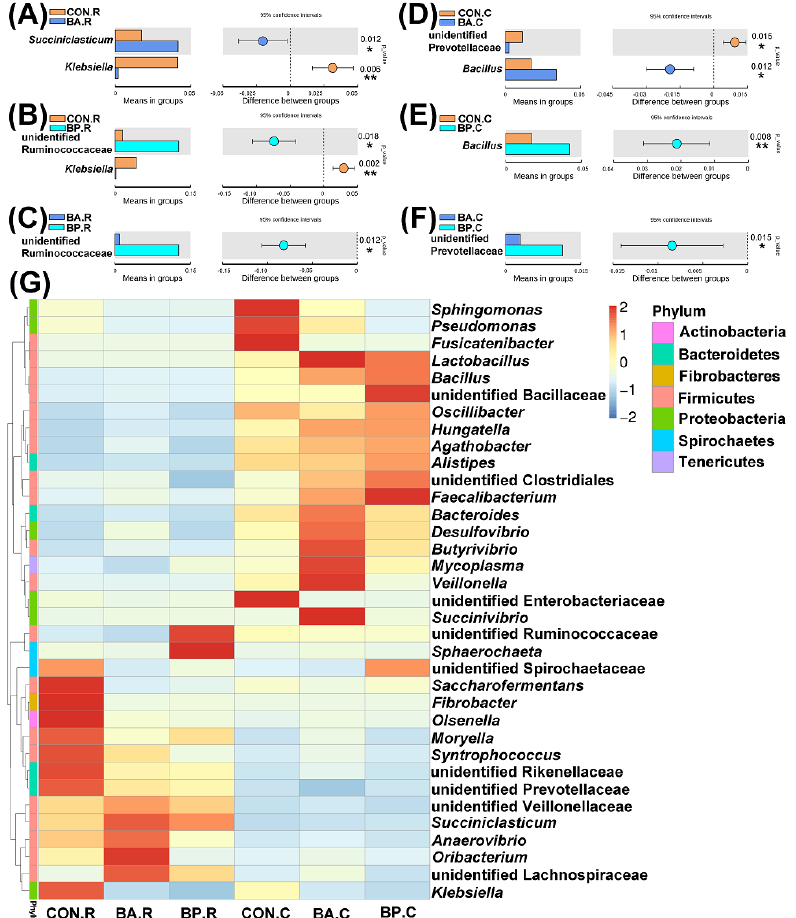
Figure 4. Analyses and heatmap of microbial community. ( A – F ) Differences in microbial community at the genera levels by the Student’s t-test. ( G ) Microbial community heatmap at the genera levels. BA.R, BP.R, and CON.R indicate rumen content samples of BA-treated, BP-treated, and control groups, respectively; BA.C, BP.C, and CON.C indicate caecum feces samples of BA-treated, BP-treated, and control groups, respectively. * p < 0.05, ** p < 0.01.